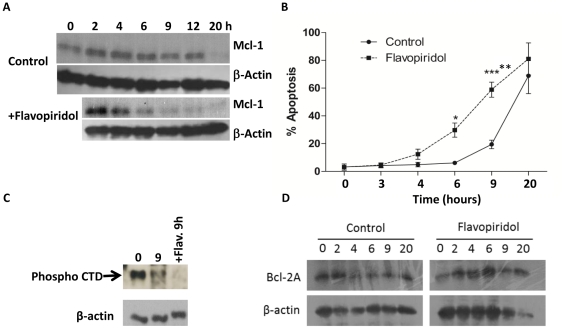
Flavopiridol treatment accelerates loss of Mcl-1.(a) Isolated human neutrophils were cultured in the absence (control) or presence of 100 nM flavopiridol for 0-20 h and Mcl-1 protein expression measured by western blotting. Blots were probed for β-actin to confirm equal loading. (b) In the same experiments neutrophil apoptosis was determined by measurement of DiOC6 uptake. Data are expressed as the % of apoptotic cells in the control (solid line) and flavopiridol (broken line) treated cultures and are mean ± s.d. for four separate experiments. * indicates p<0.05 and ** indicates p<0.01 for control versus flavopiridol treated cells. (c) CDK9 activity was measured in control, flavopiridol (100 nM) and flavopiridol plus GM-CSF (50 ng/ml) treated neutrophils by immunoprecipitating CDK9 from neutrophils with a monoclonal anti-CDK9 antibody and determining activity by assessing incorporation of [γ 32P]-ATP into the CTD of RNA polymerase II. The phosphorylated peptide was isolated on an SDS-PAGE gel and visualised by autoradiography. The image shown is representative of 3 separate experiments performed. (d) Isolated human neutrophils were cultured in the absence (control) or presence of 100 nM flavopiridol for 0–20 h and Bcl2A protein expression measured by western blotting. Blots were probed for β-actin to confirm equal loading.